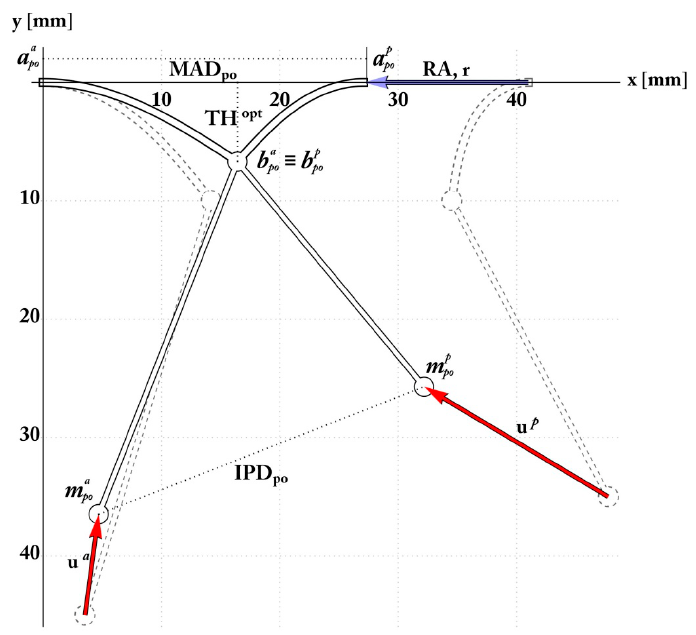
Figure 7. Analytically determined postoperative configuration showing mitral valve (MV) restriction, leaflet coaptation, and optimal interpapillary muscle distance (IPMD) ensuring the minimum stress within the tethering chordae. Materials 2019 , 12 , x FOR PEER REVIEW